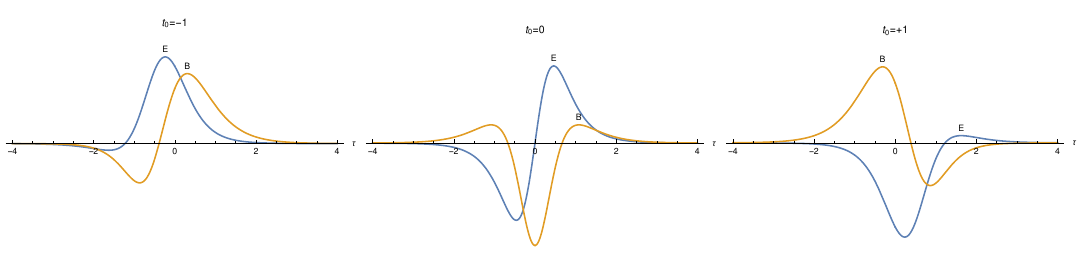
Figure 2 . Electric and magnetic amplitudes for the bounce configuration (3.23b) with t 0 =